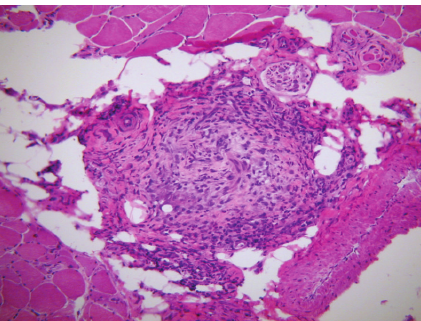
Figure 2: Case 2. Cryostat section of muscle stained with hematoxylin and eosin demonstrates an intramuscular arteriole with mural infiltrate of lymphocytes and histiocytes and luminal obliteration. No eosinophils were present; however, the biopsy was obtained one week after IV corticosteroid